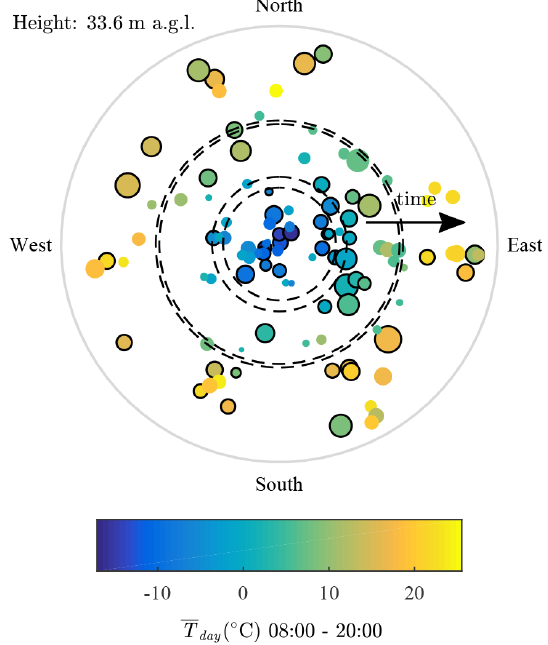
Figure A4. Wind rose illustrating multiple aerosol features, including relative average particle concentration (calculated from the SMEAR II DMPS and APS concentrations) and NPF events, as a function of air temperature, wind direction and time at 33.6m above ground level on the